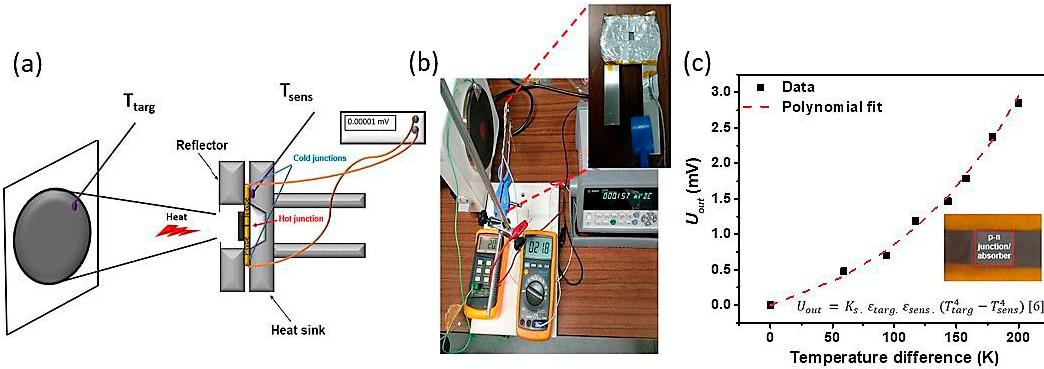
Figure 3. ( a ) Scheme of operation of the TE device used as radiation sensor; ( b ) thermal test ( c ) output voltage plotted against the temperature difference (T targ − T sens ); inset: photograph of the sensor and equation